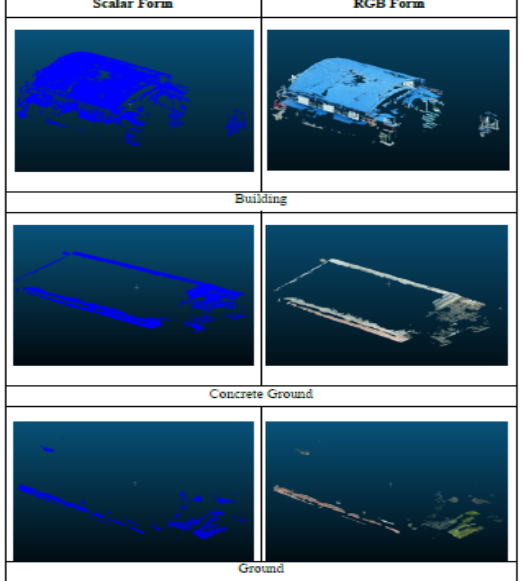
Table 1: Scalar-Based Segmentation results